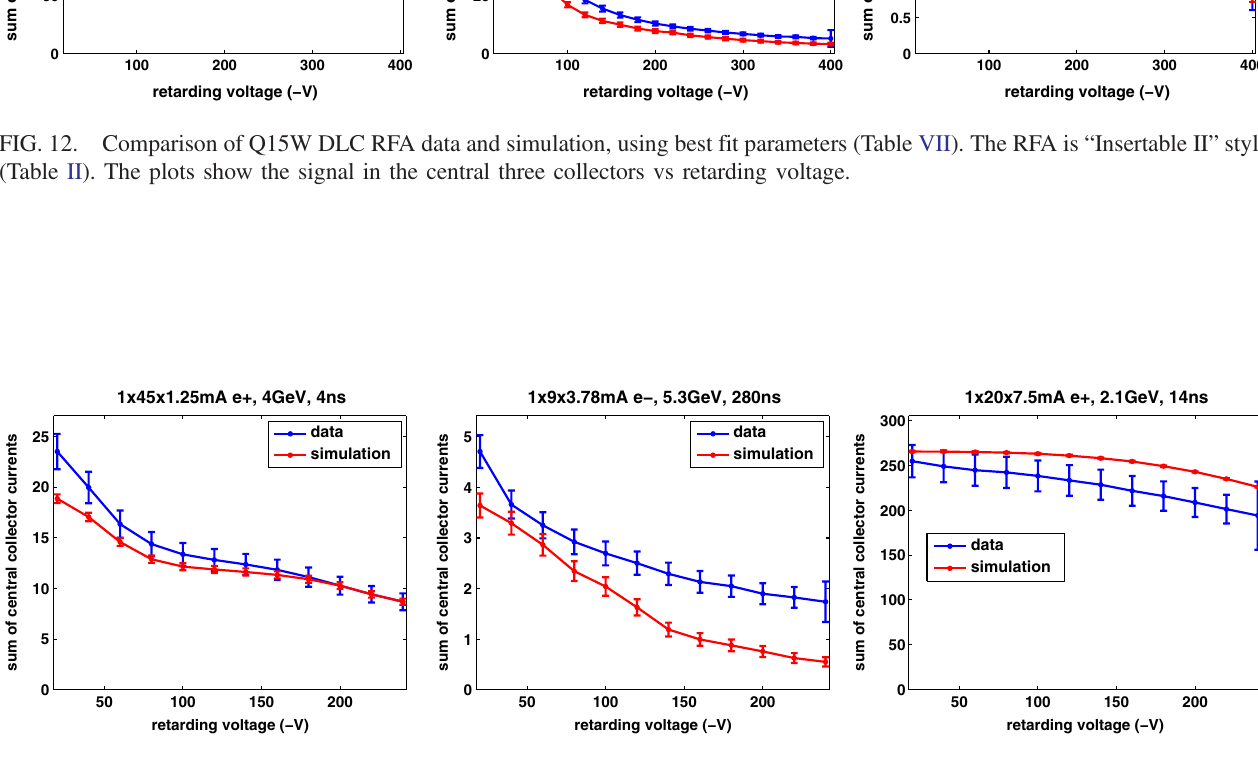
FIG. 13. Comparison of Q14E Cu RFA data and simulation, using best fit parameters (Table VII). The RFA is “ Insertable I ” style (Table II). The plots show the signal in the central three collectors vs retarding